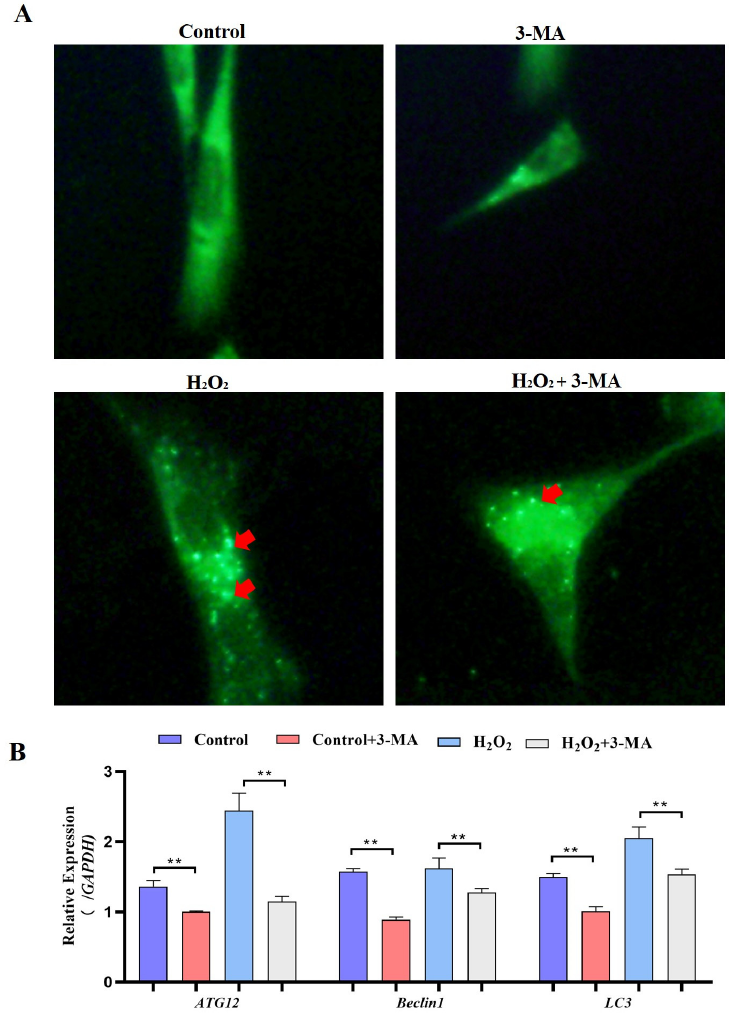
Figure 9. Oxidative stress conditions inhibit autophagy. ( A ) For the MDC assay, GCs were treated with H 2 O 2 in the presence or absence of 3-MA for 4 h. Following this incubation period, the cells were incubated with 0.05 mM MDC for 10 min at 38.5 ◦ C and then washed 4 times with PBS (pH 7.4). The cells were immediately analyzed by fluorescence microscopy and quantified. Red arrow: Laser confocal scanning microscopy was used to observe the fluorescent autolysosomes puncta in GCs. ( B ) Expression of Atg12 , Beclin1 , LC3 and p62 after treatment with H 2 O 2 in the presence or absence of 3-MA for 4 h ( n = 3). ** indicates an extremely significant difference ( p <